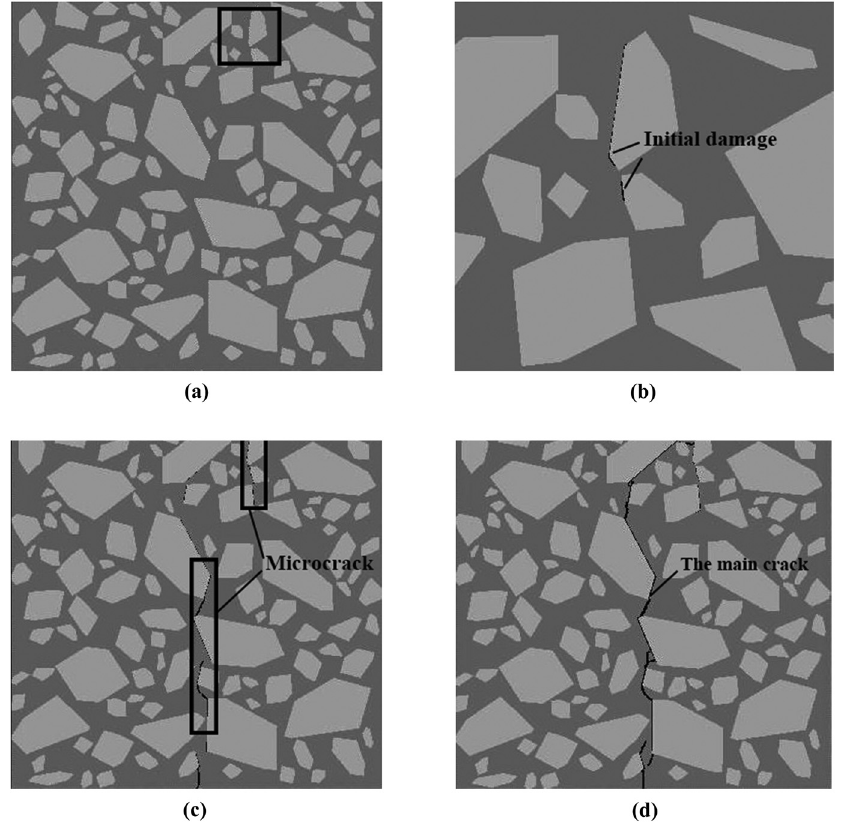
Figure 9: Crack opening process in plain concrete. ( a ) Initial damage phase ( incremental step 25 ) , ( b ) enlarged view of the initial damage area, ( c ) cracks in expansion ( incremental step 100 ) , and ( d ) fi nal crack morphology ( incremental step 200 )